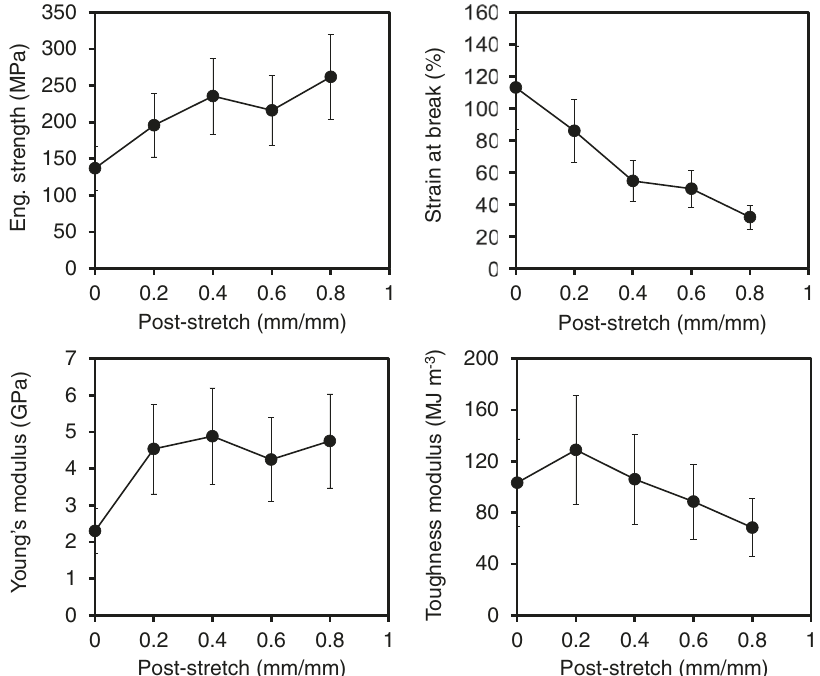
Fig. 9 In fl uence of post-spin stretching on the mechanical properties of as-spun NT2RepCT fi bers. The NT2RepCT fi bers were stretched by either 0% ( n = 20), 20% ( n = 8), 40% ( n = 8), 60% ( n = 6), or 80% ( n = 7) their original length, with a tensile tester. After this treatment, the fi bers were recovered, the diameter was determined before the fi bers were fi nally tensile tested. Each data point represents the average with error bars indicating ± one standard deviation. The corresponding stress-strain curves are shown in Supplementary Fig.